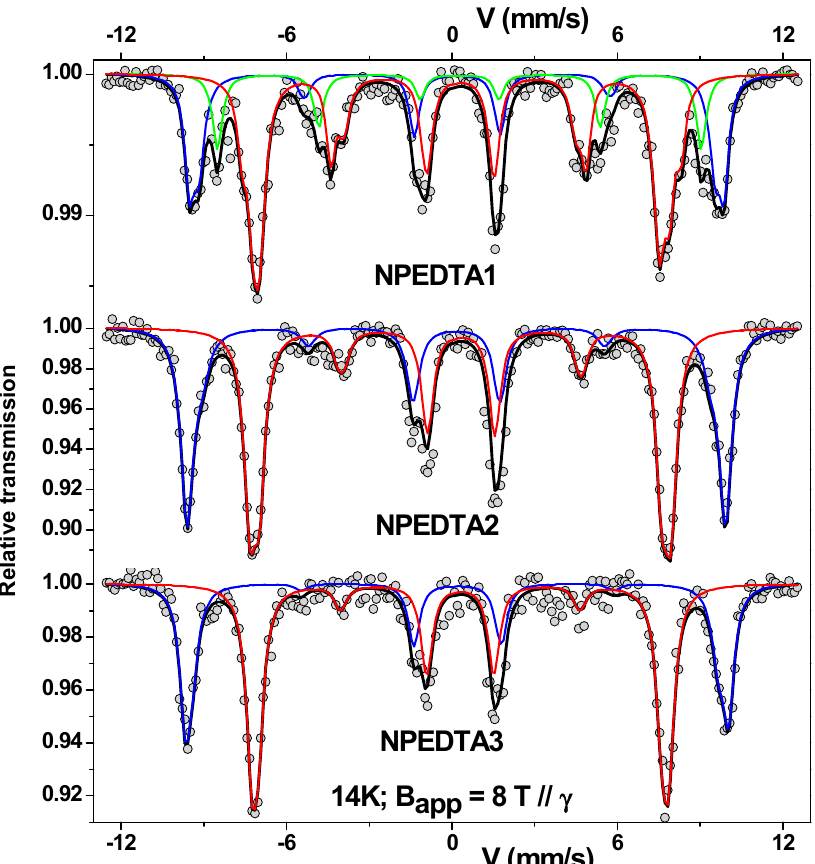
Figure 4. In-field Mössbauer spectra taken at 14 K in an applied field of 8 T for the ethylenediaminetetraacetic acid (EDTA) functionalized γ -Fe 2 O 3 NPs (NPEDTA). Mössbauer spectra of the NPEDTA2 and NPEDTA3 were reproduced with permission of Elsevier [30]. 1, 2, and 3 indicates different routes of synthesis that can be checked in [30]. The lines red and blue represent the crystalline sites of γ -Fe2O3 NPs while the green line for NPEDTA1 sample is related to the surface magnetic contribution. Table 1. Refined mean values of hyperfine parameters estimated from the in-field Mössbauer spectra recorded at 14 K under an 8 T external magnetic field applied parallel to the γ -ray beam for the NPEDTA1 (4.0 nm). In case of NPEDTA2 (7.6 nm) and NPEDTA3 (7.0 nm) samples were taken from [30]. A and B are related to the tetrahedral and octahedral sites of the γ -Fe 2 O 3 phase. Notice that all hyperfine parameters here corresponded to a nano 2 O 3 with a size smaller than 10 nm. F (%) denotes the atomic proportions for site A and B, respectively. e is the canted spin surface layer. < (cid:101) > is the quadrupolar shifting, B eff is the total effective field, and < B hf > is the mean hyperfine magnetic field.